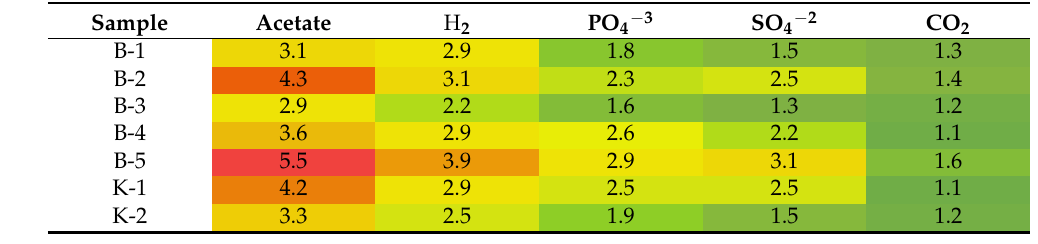
Table 7. Stimulation of the respiratory activity of clay microbial complexes by the components of cement and glass barrier degradation and radiolysis products.